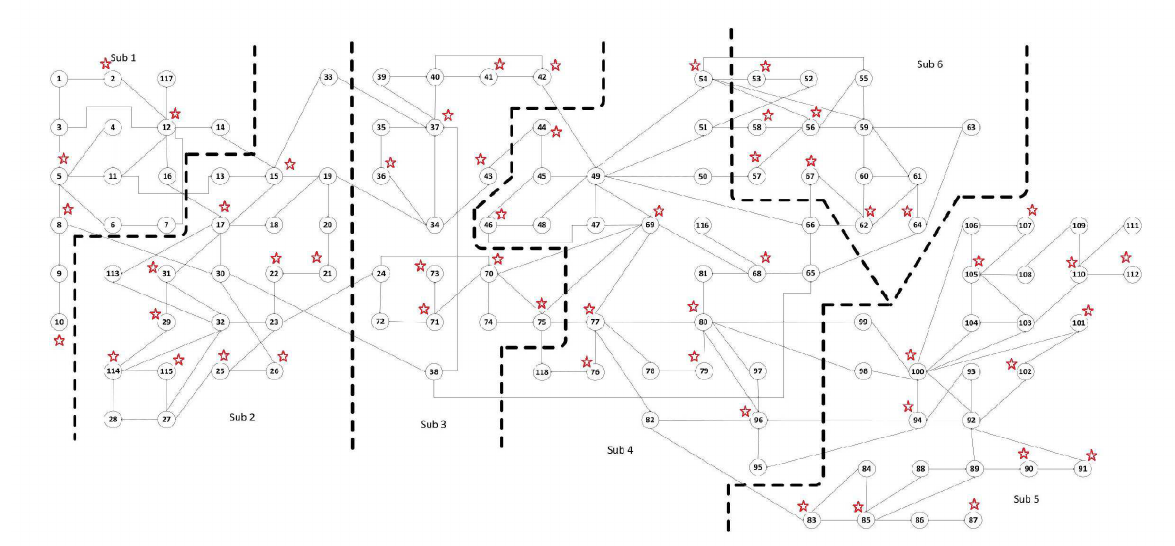
Figure 10. The IEEE 118-bus system installed with 54 PMUs is separated into 6 local areas (subsystems) [34].